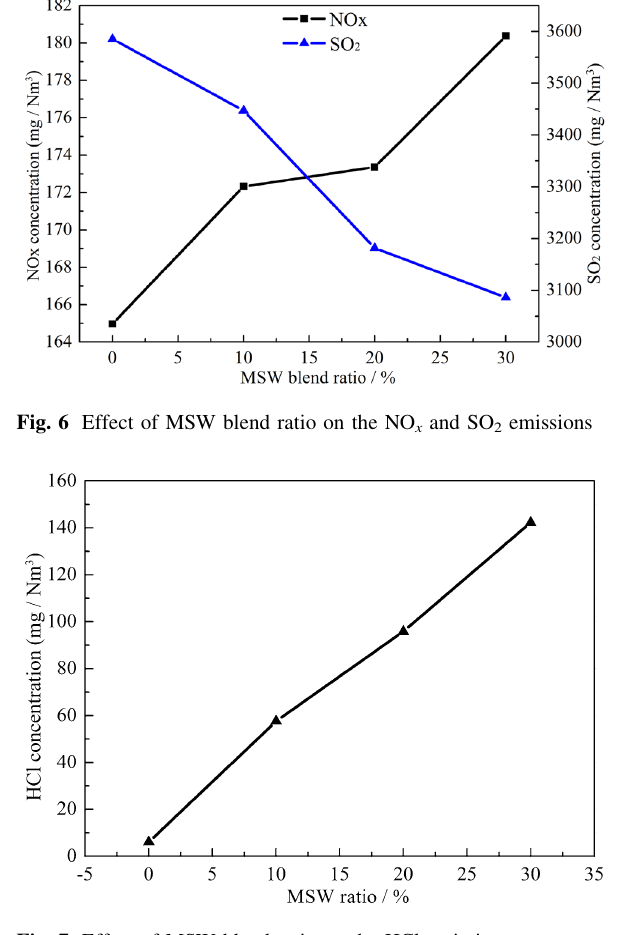
Fig. 7 Effect of MSW blend ratio on the HCl emission Table 2 Conversion rate of nitrogen, sulfur and chlorine at different MSW blend ratio MSW